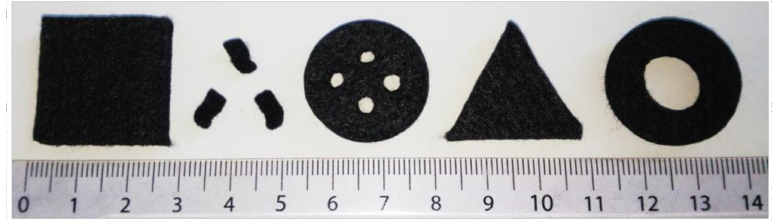
Figure 3. Graphite felts with different macroscopic shapes for various catalytic applications both in gas- and liquid-phase